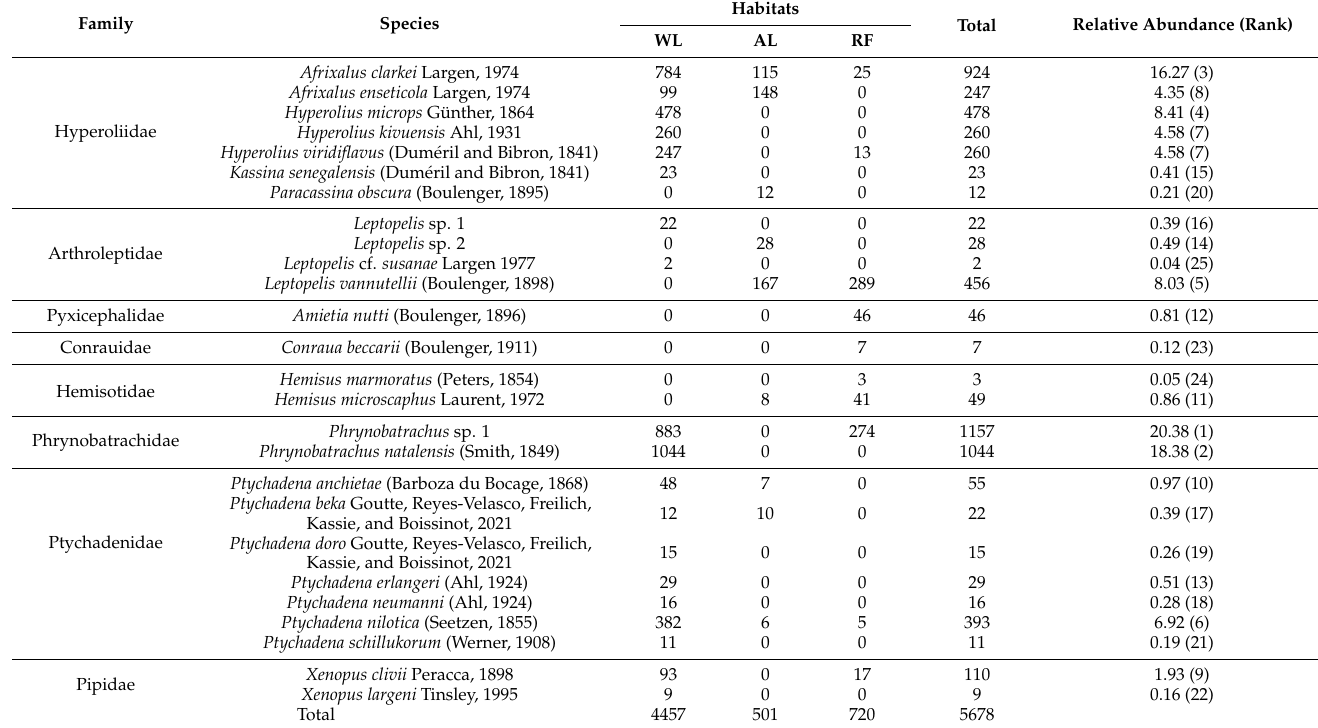
Table 2. Abundance of anuran species recorded in three habitat types of